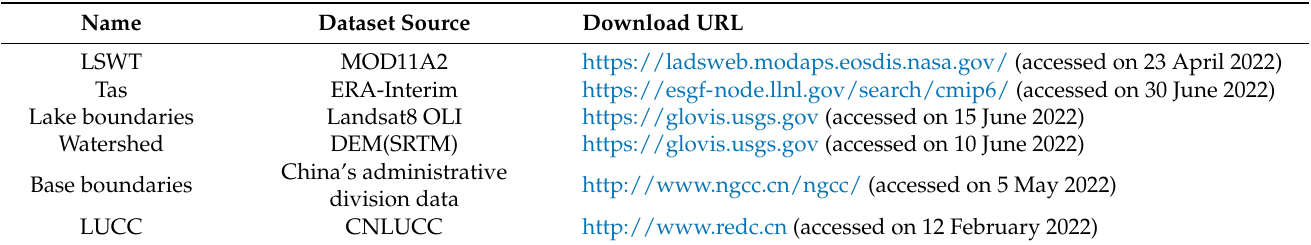
Table 1. Research data